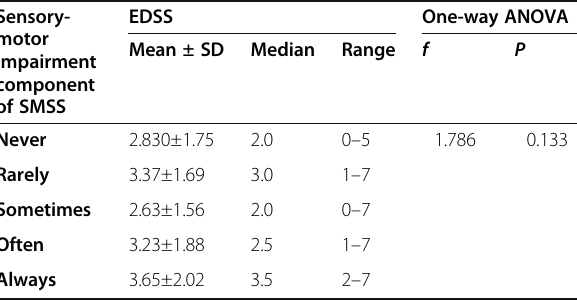
Table 7 Comparison of EDSS scores in the sensory-motor impairment component of SMSS Sensory- motor